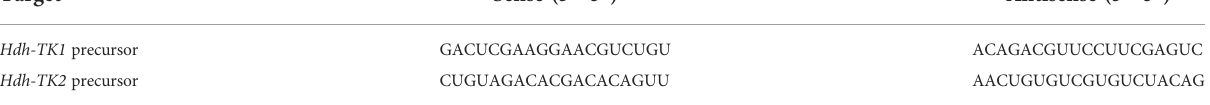
TABLE 3 siRNAs used in the RNA interference